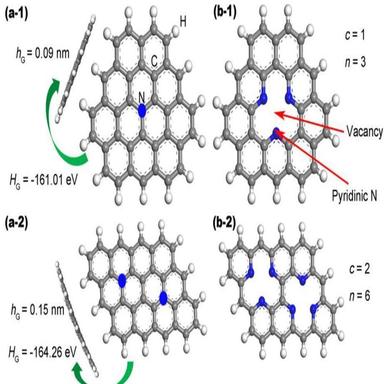
Optimized structures of N-G doped by: (a-1) one Ca atom, (b-1) one Al atom, (c-1) one Mg atom, (d-1) one Si atom, (a-2) two Ca atoms, (b-2) two Al atoms, (c-2) two Mg atoms, and (d-2) two Si atoms. (A colour version of this figure can be viewed online.)